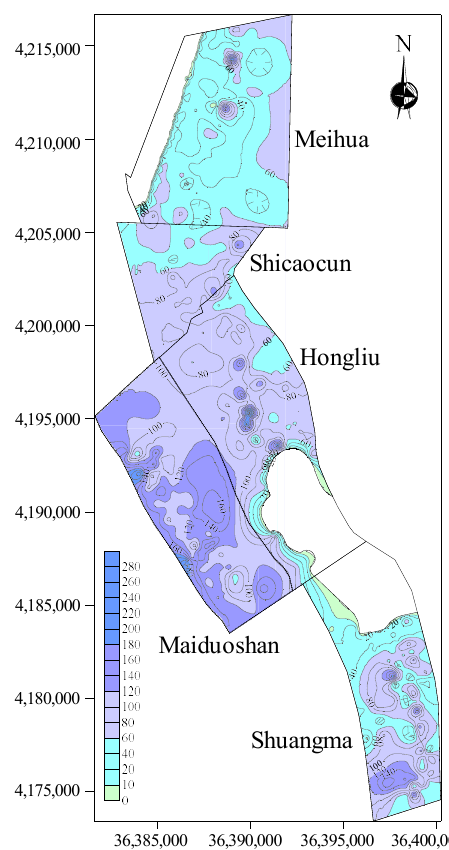
Figure 10. Contour map of sandstone thickness within the development range of the water-conducting fracture zone of the main coal seam roof in the study area.